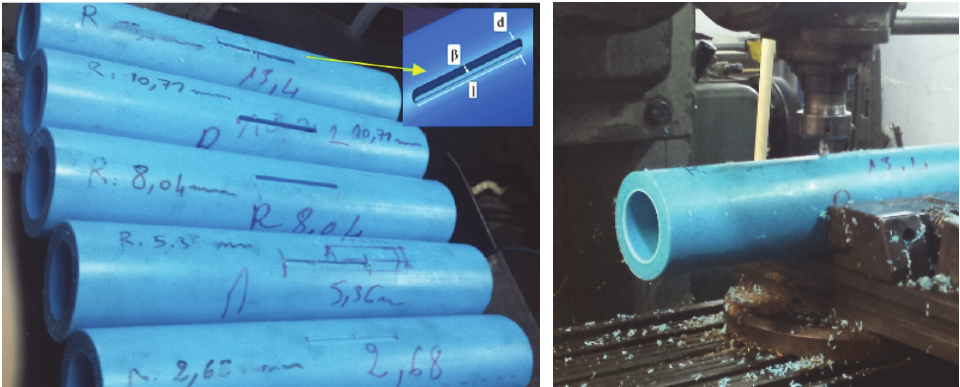
Figure 2: Groove Notch preparation and dimensions.